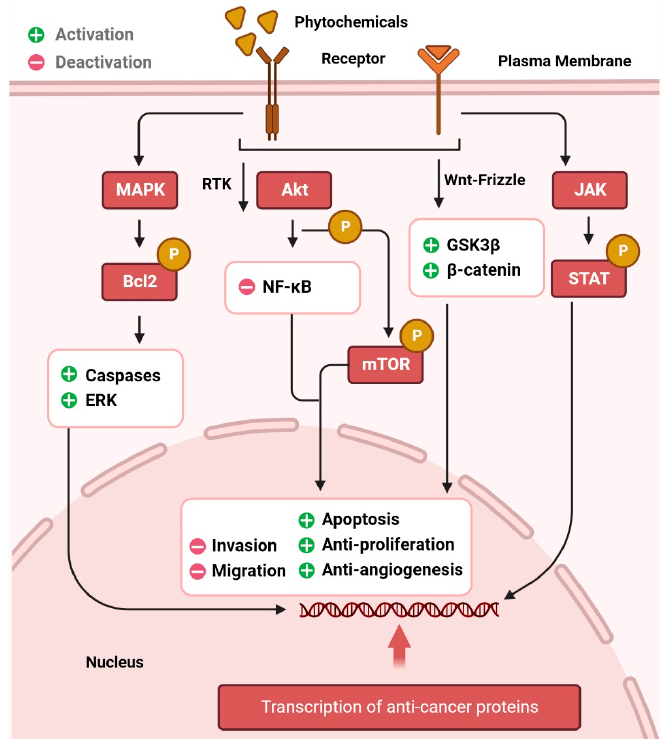
Figure 1. Cancer chemoprevention through the phytochemical interaction with signaling molecules. The image illustrates how phytochemicals activate MAPK, Akt, Wnt, and JAK/STAT pathways, leading to cancer cell death through many intracellular signaling molecules.